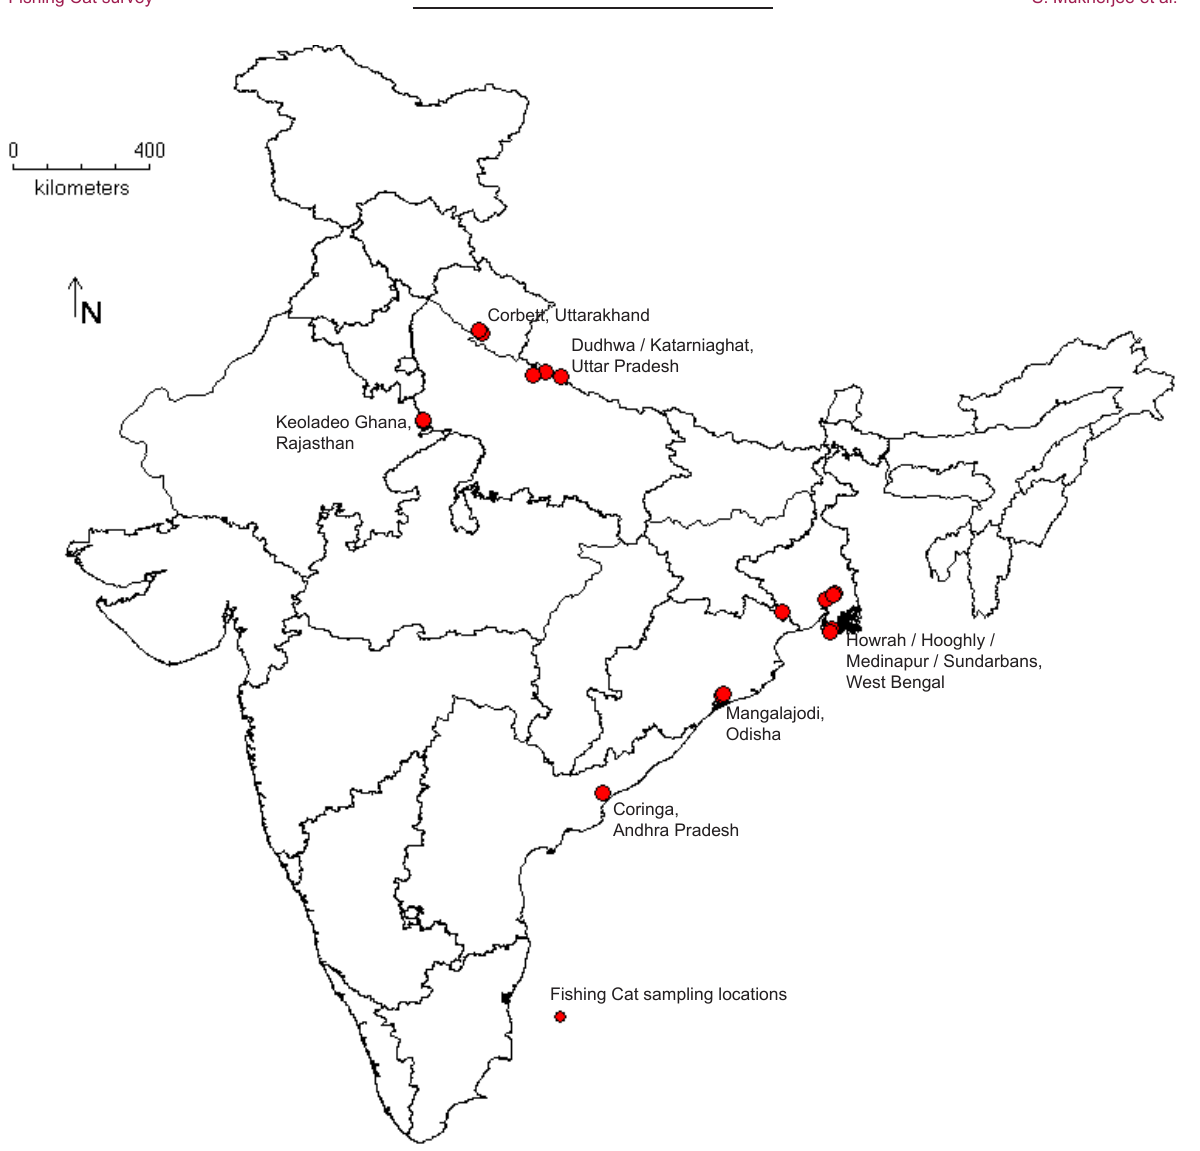
Figure 1. Locations of sampling for